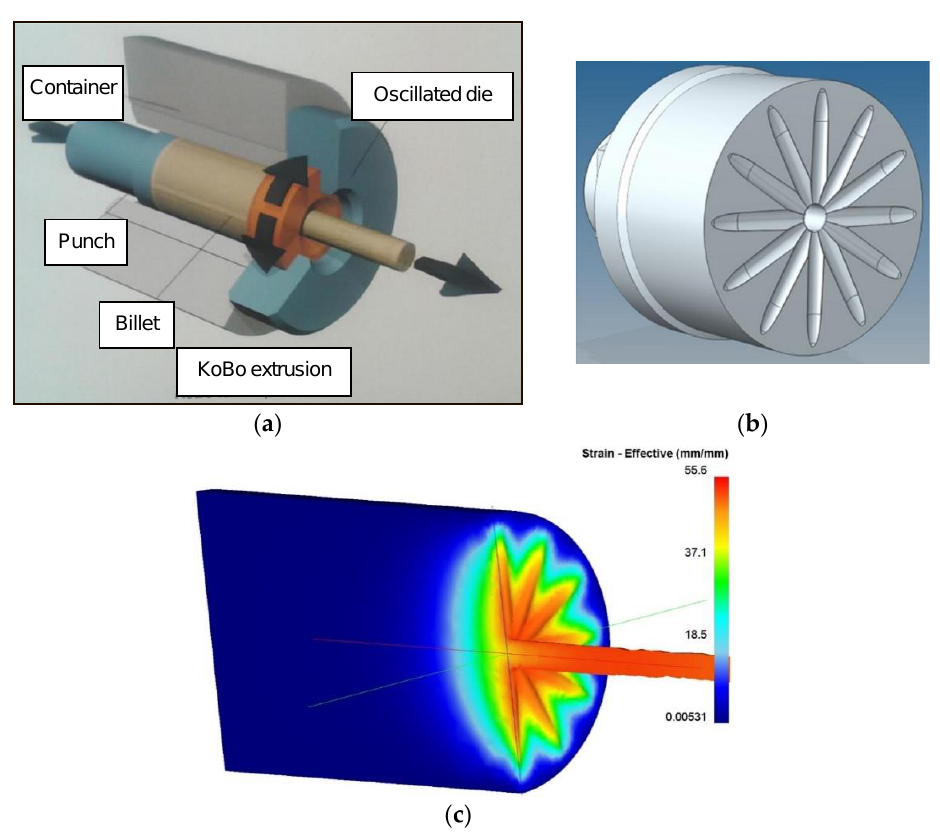
Figure 1. Scheme of KoBo extrusion process ( a ), view of die used for extrusion ( b ), result of FEM computer simulation of extrusion process, (c) deformation intensity distribution